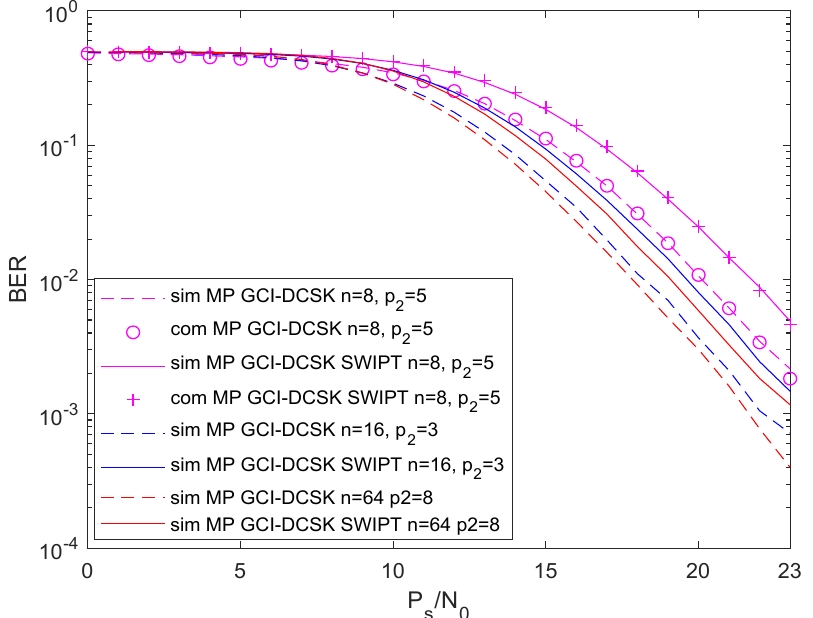
Figure 8. BER performance of GCI-DCSK SWIPT compared to GCI-DCSK over a multipath Rayleigh fading